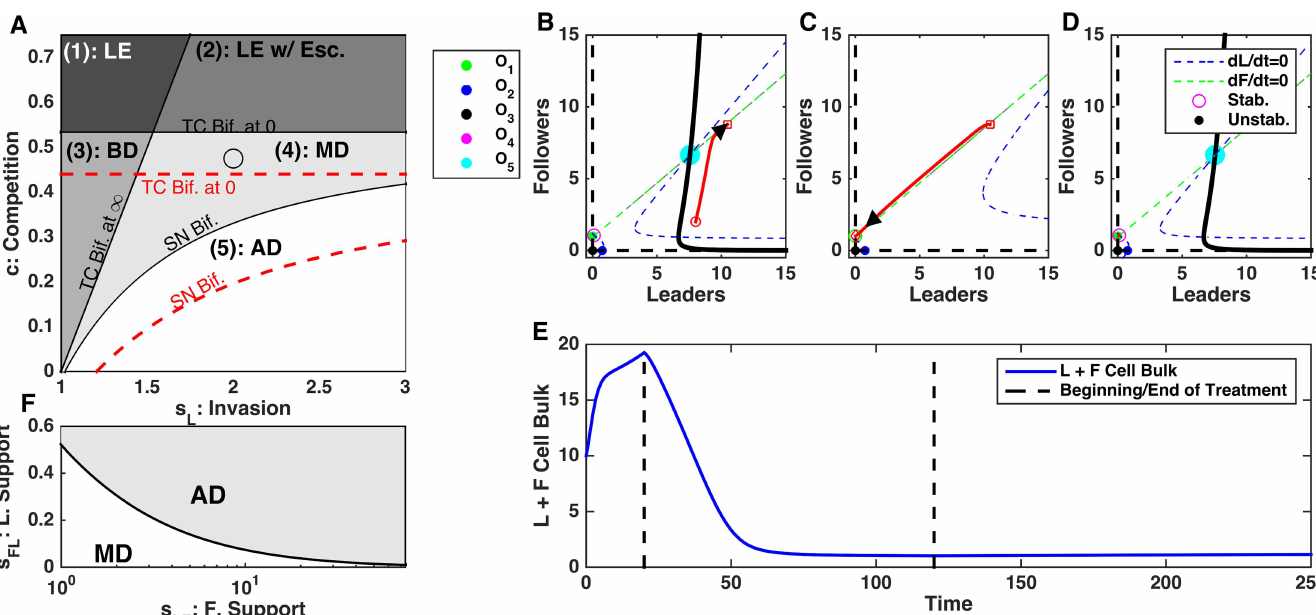
Fig 8. Disrupting follower to leader feedback, s FL , can have irreversible changes in dynamics leading to stabilization of cell count. A) Bifurcation diagram depicting the direction of the perturbation in parameter space. Perturbations in s change the location of the saddle node bifurcation and transcritical bifurcation at zero FL boundaries. Black lines–initial location of the bifurcation boundaries; red lines–perturbed location. B-D) Phase plots of dynamics before (B), during (C), and after (D) blockade of s . E) Time-course of cell count. Note irreversible change of the ecosystem dynamics. F) Bifurcation diagram depicting the position of the saddle node FL bifurcation point as a function of s LF and s FL . AD: Aggressive Dynamics; MD: Multi-modal Dynamics. Here, s L = 1.4 and c = 0.2.